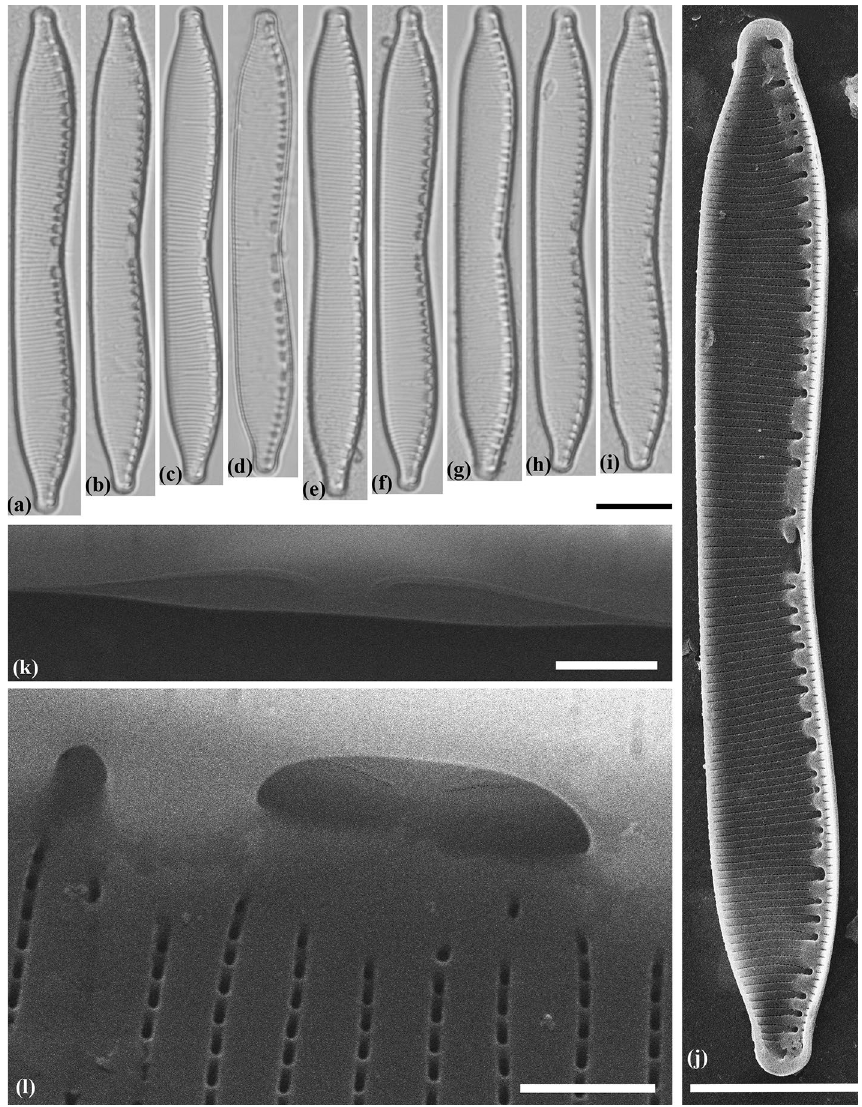
Figure 4. Valve morphology of the strain Hantzschia attractiva MZ–BH11. ( a – d ) Light micrographs of the natural population. ( e – i ) Light micrographs of monoculture. ( j ) Scanning electron micrographs, interior of valve. ( k ) Scanning electron micrograph, showing the raphe keel. ( l ) Scanning electron micrograph, interior of valve at valve center, showing the bent of the raphe near the central raphe endings. Scale bars ( a – j ) = 10 µm, ( k – l ) = 1